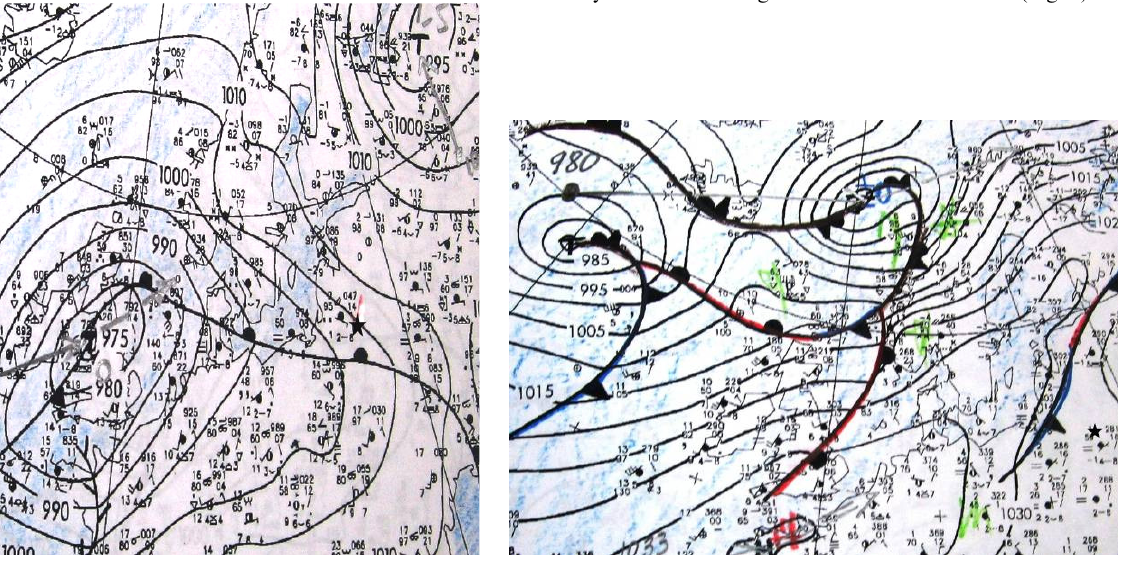
Fig. 11. 22 Oct. 2002 14 h. No HCRF decease. Fig. 14. 25 Jan. 2003 14 h. Time interval 12–13 hours